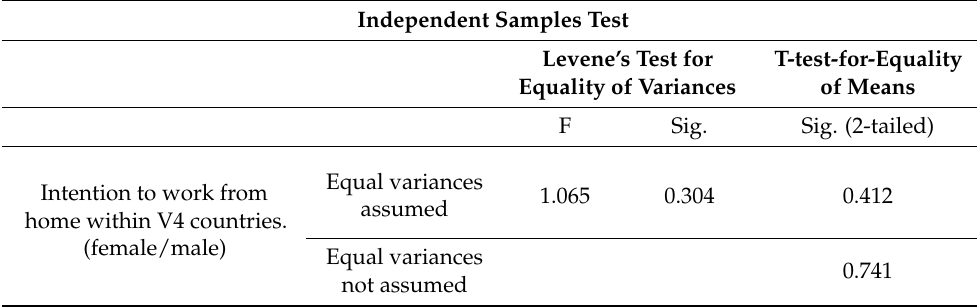
Table 6. Independent samples tests for V4 countries workers’ future intention to work from home, case females vs. males.